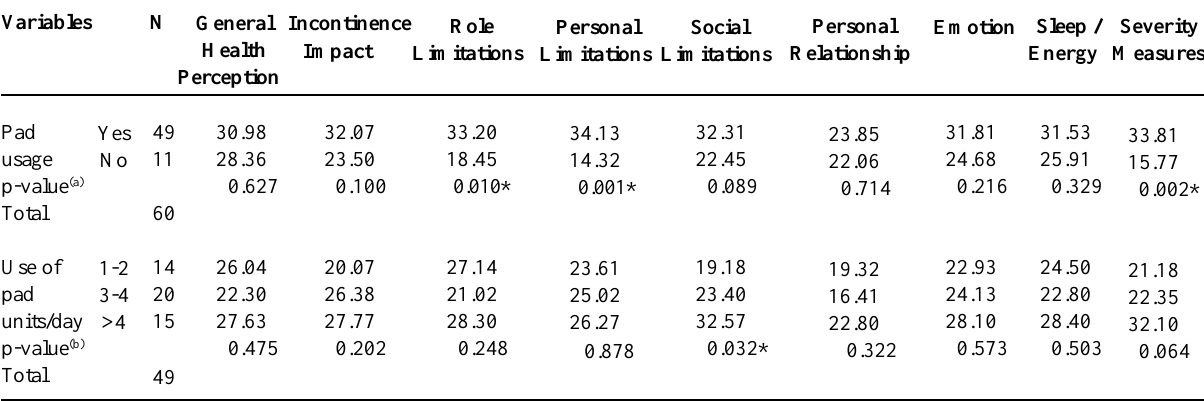
Table 3 – Concurrent Validity: descriptive statistics of mean scores from each King’s Health Questionnaire domain and the clinical variables and respective comparisons among categories concerning to urinary